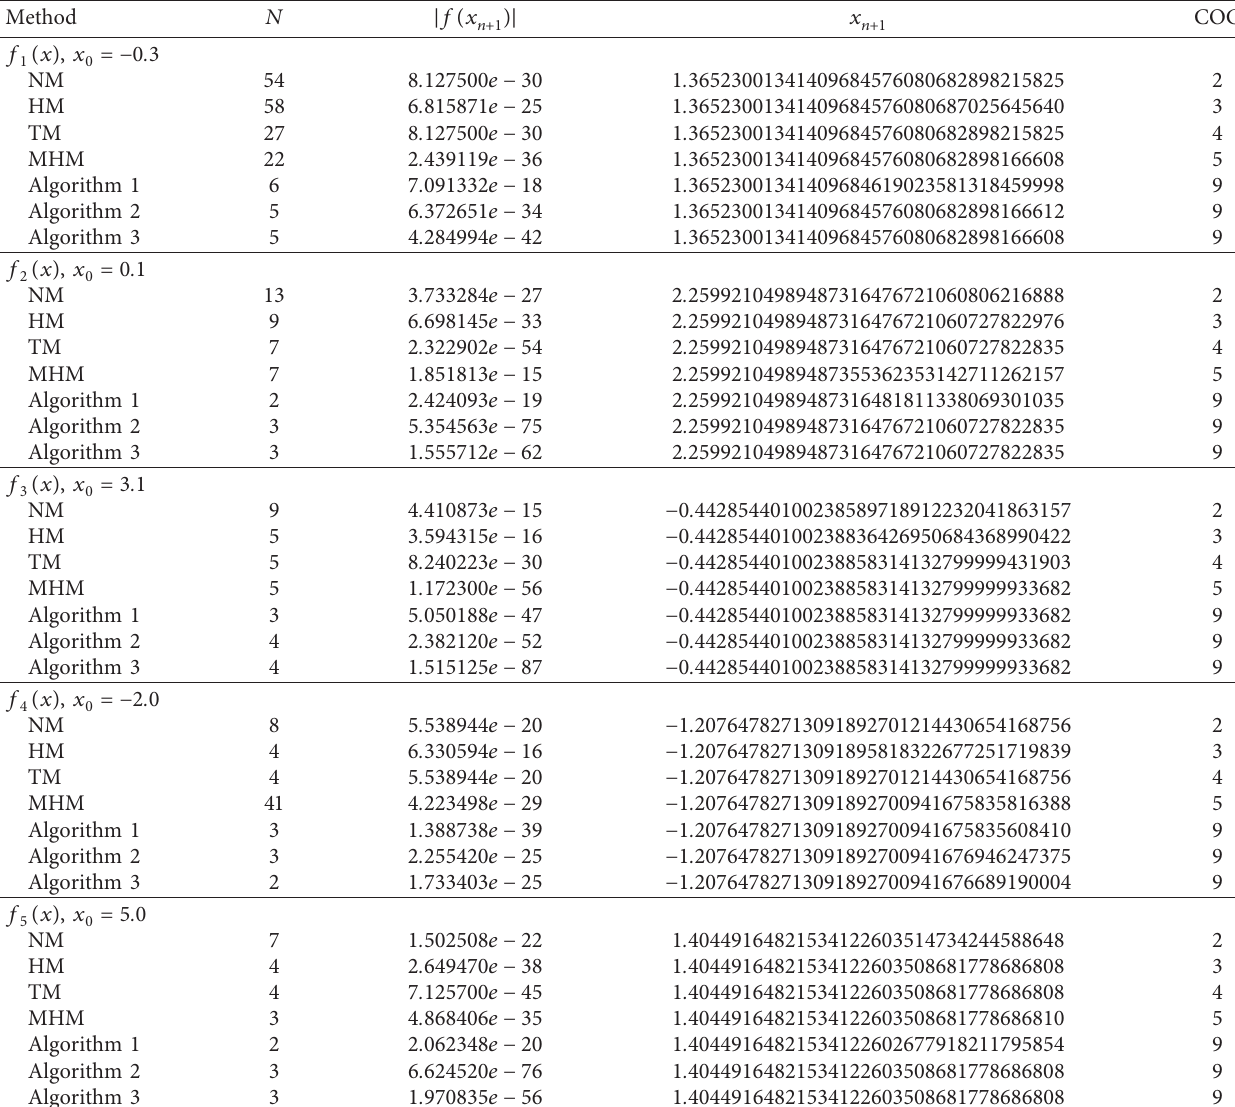
Table 1: Comparison of NM, HM, TM, MHM, and Algorithms 1–3.